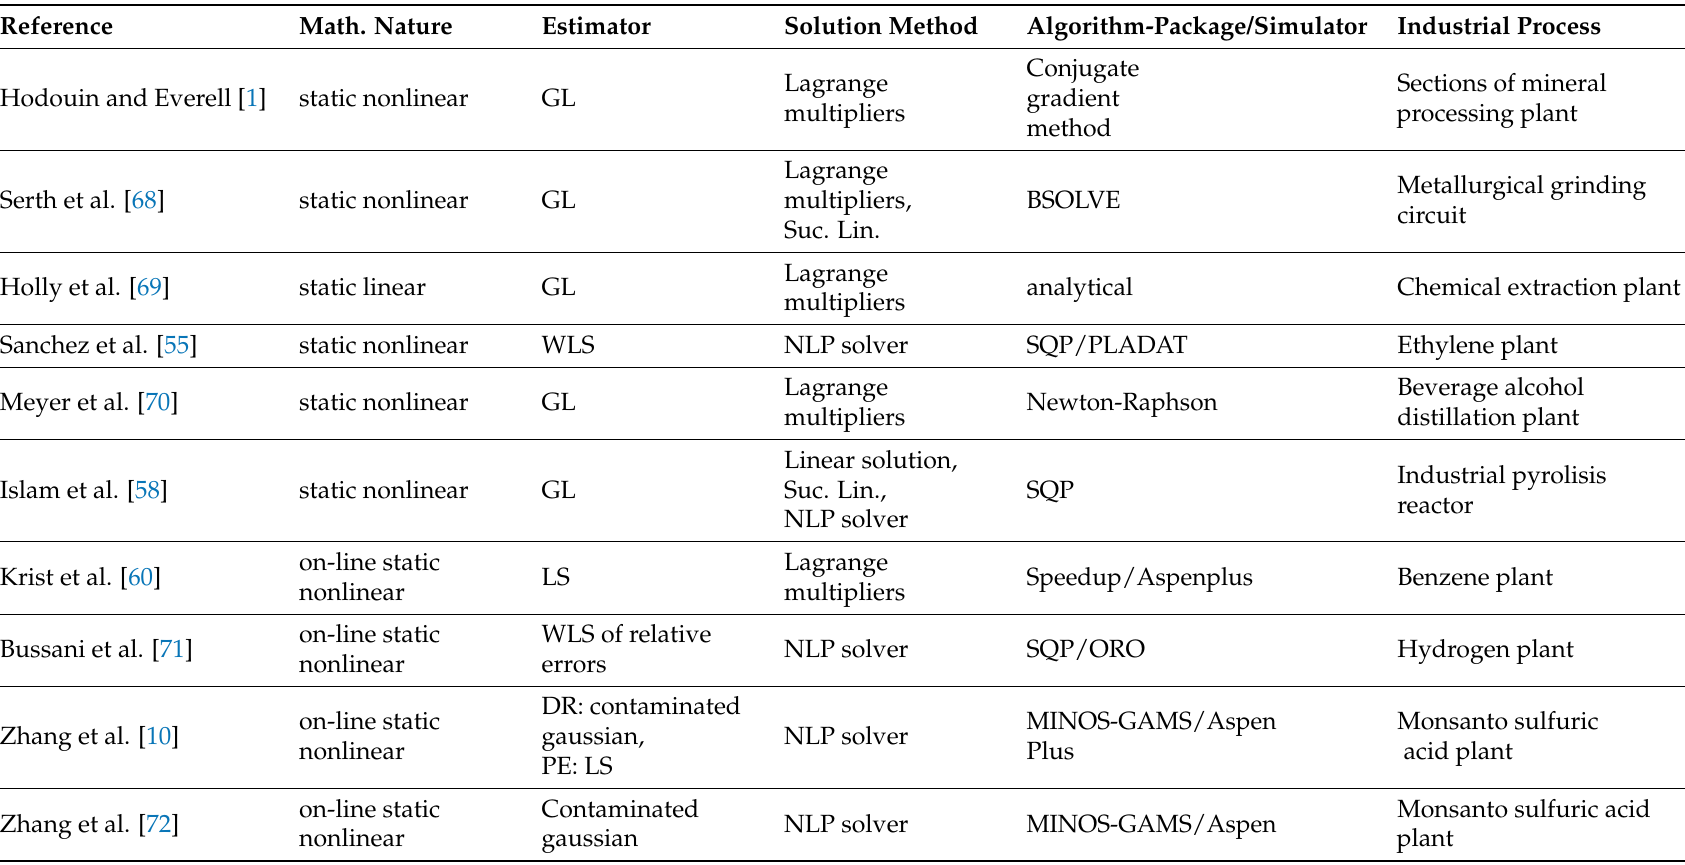
Table 1. Real industrial applications of data reconciliation techniques or data reconciliation studies involving real plant